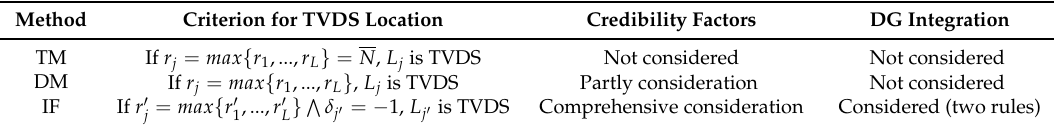
Table 3. Criteria and features of different